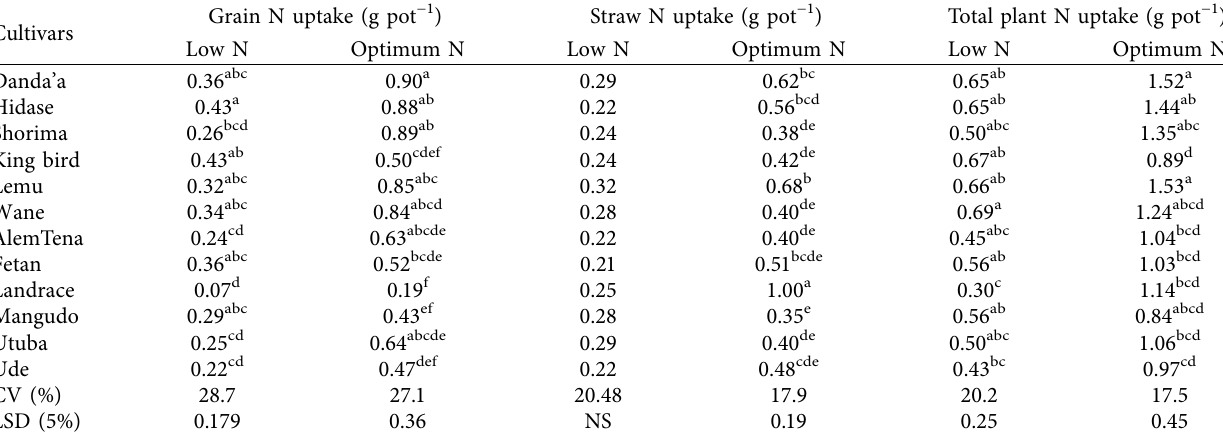
Table 3: Grain and straw N concentration and N uptake of wheat cultivars. Cultivars